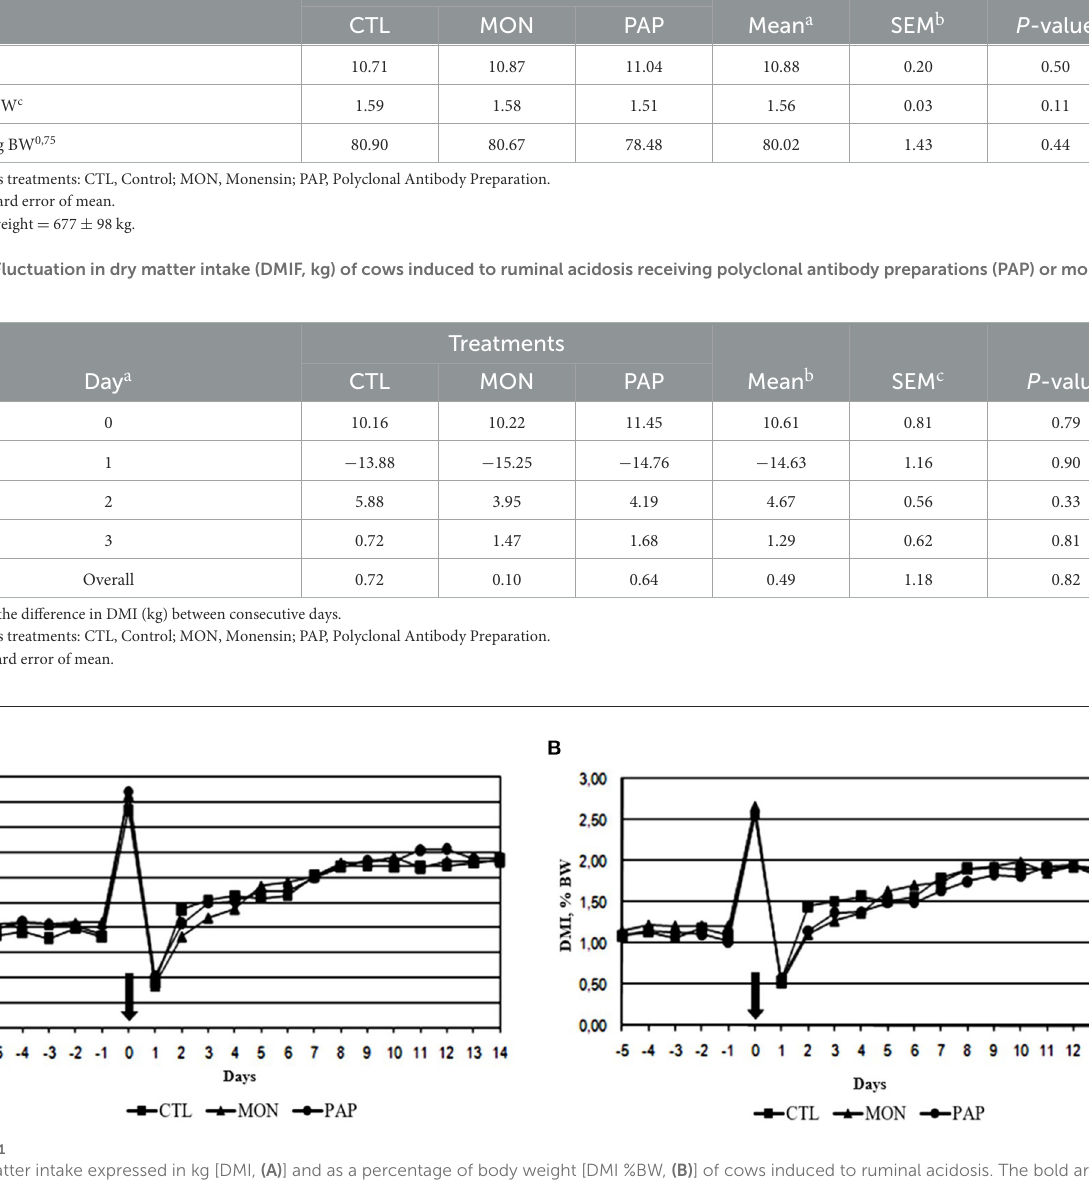
TABLE 2 Dry matter intake in kg (DMI, kg/d), DMI as a percentage of body weight (DMI, %BW), and DMI based on metabolic BW (DMI, g/kg BW0.75) of cows induced to ruminal acidosis receiving polyclonal antibody preparations (PAP) or monensin (MON). Treatments